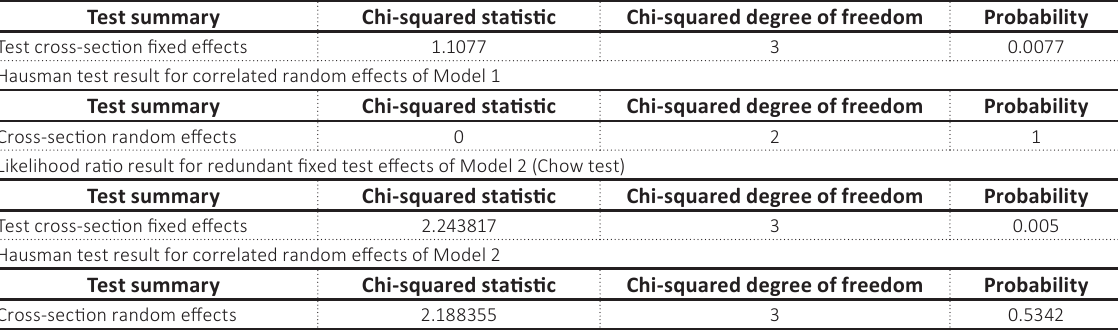
Table 1B. Likelihood ratio result for redundant fixed test effects of Model 1 (Chow